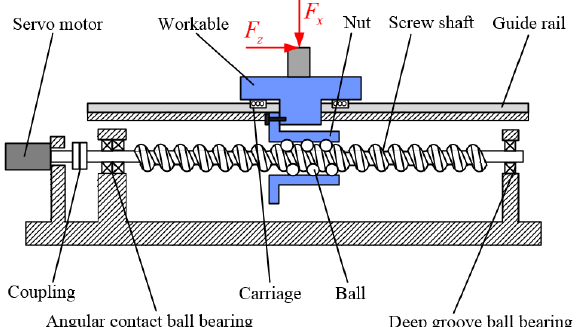
Figure 1. Structure of ball screw feed system.